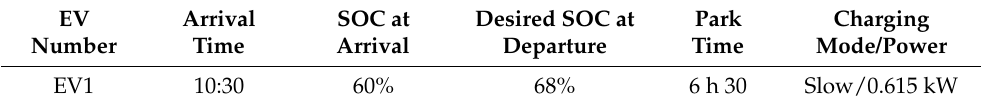
Table 2. Hypotheses for Scenario 1b.